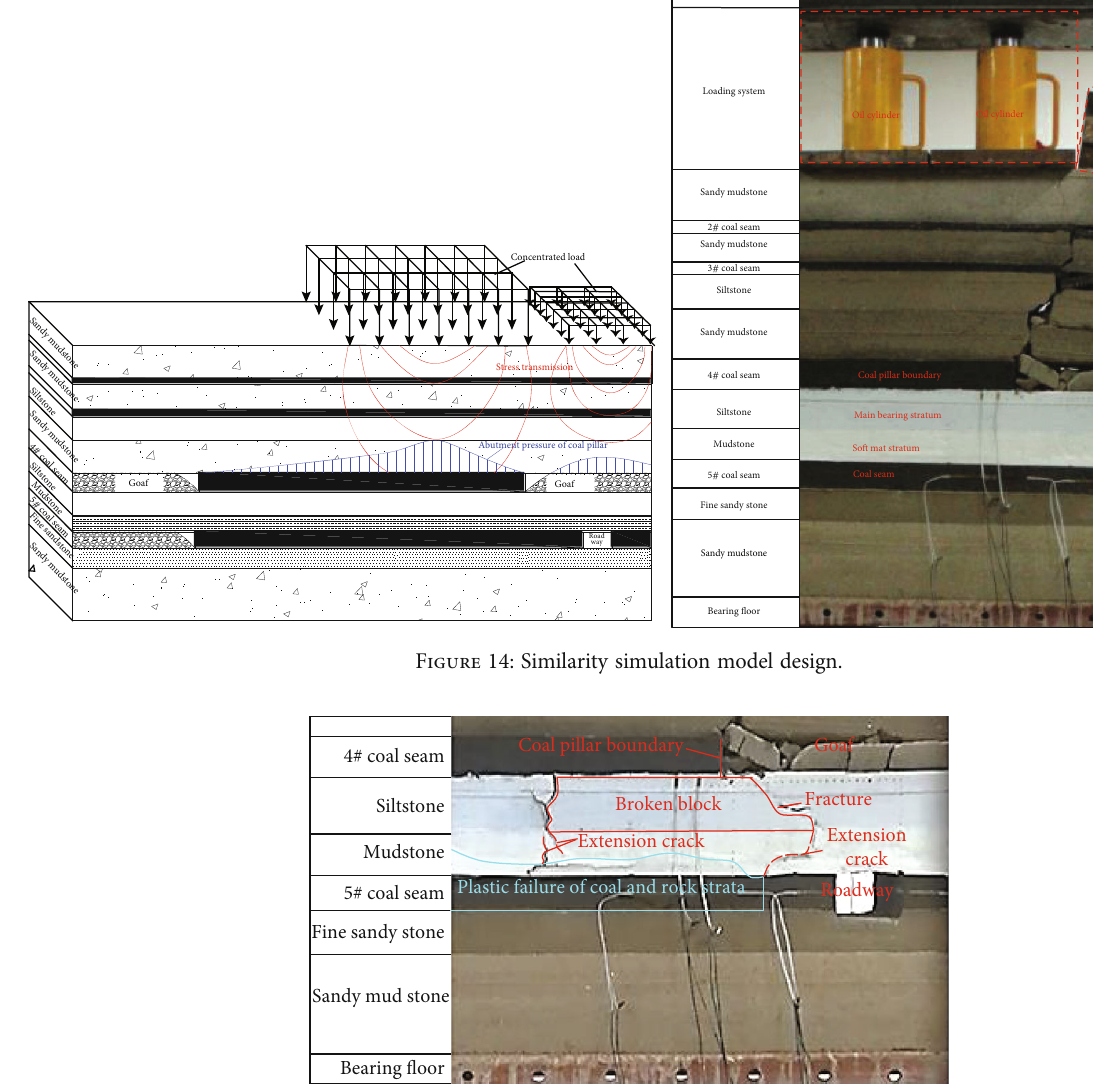
Figure 15: Failure of strata under coal pillar.